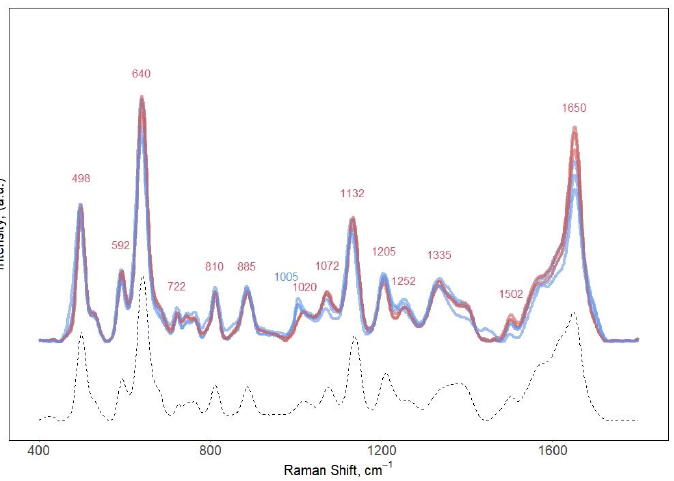
Figure 2. Comparison between the SERS spectra obtained with CSPPs of unprocessed (blue) and filtered (red) human serum (n = 3). SERS spectrum of uric acid (125 μM, dissolved in water) is re- ported as reference (dashed line). Excitation wavelength: 785 nm. filtered (red) human serum (n = 3). SERS spectrum of uric acid (125 µ M, dissolved in water) is reported as reference (dashed line). Excitation wavelength: 785